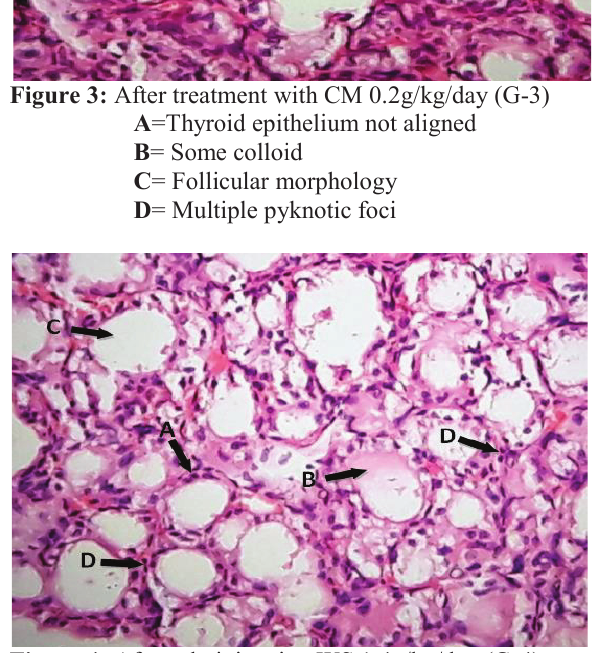
Figure 1: Showing normal thyroid histology (G-1)